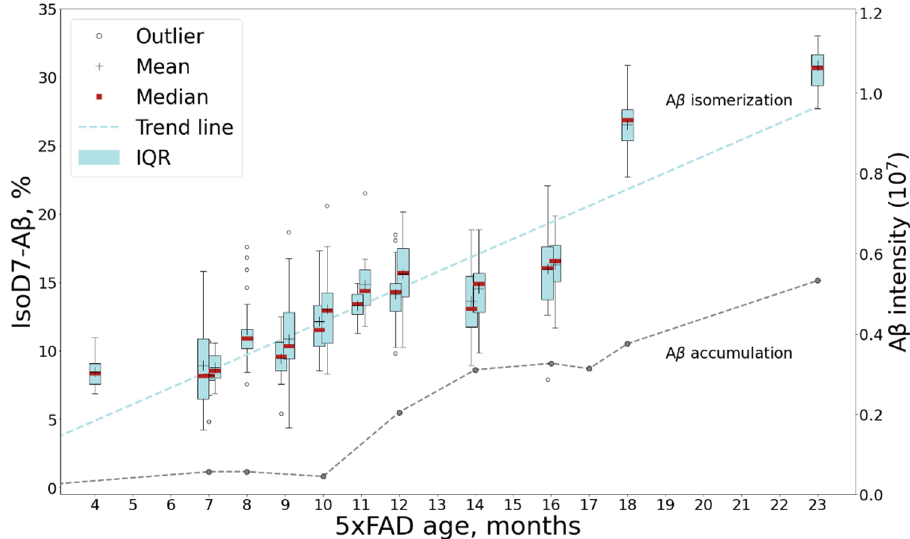
Figure 4. The dynamics of isoD7-A β content in 5xFAD mice brain samples studied by MALDI TOF/TOF. The boxplot graph shows the changes in the isoD7-A β content in samples from mice of different ages. For timescale comparison accumulation of human A β with mouse age measured by LC-MS/MS (see Figure 1) is also shown. Average values for combined mouse age groups and significance estimations can be found in Figure S7.